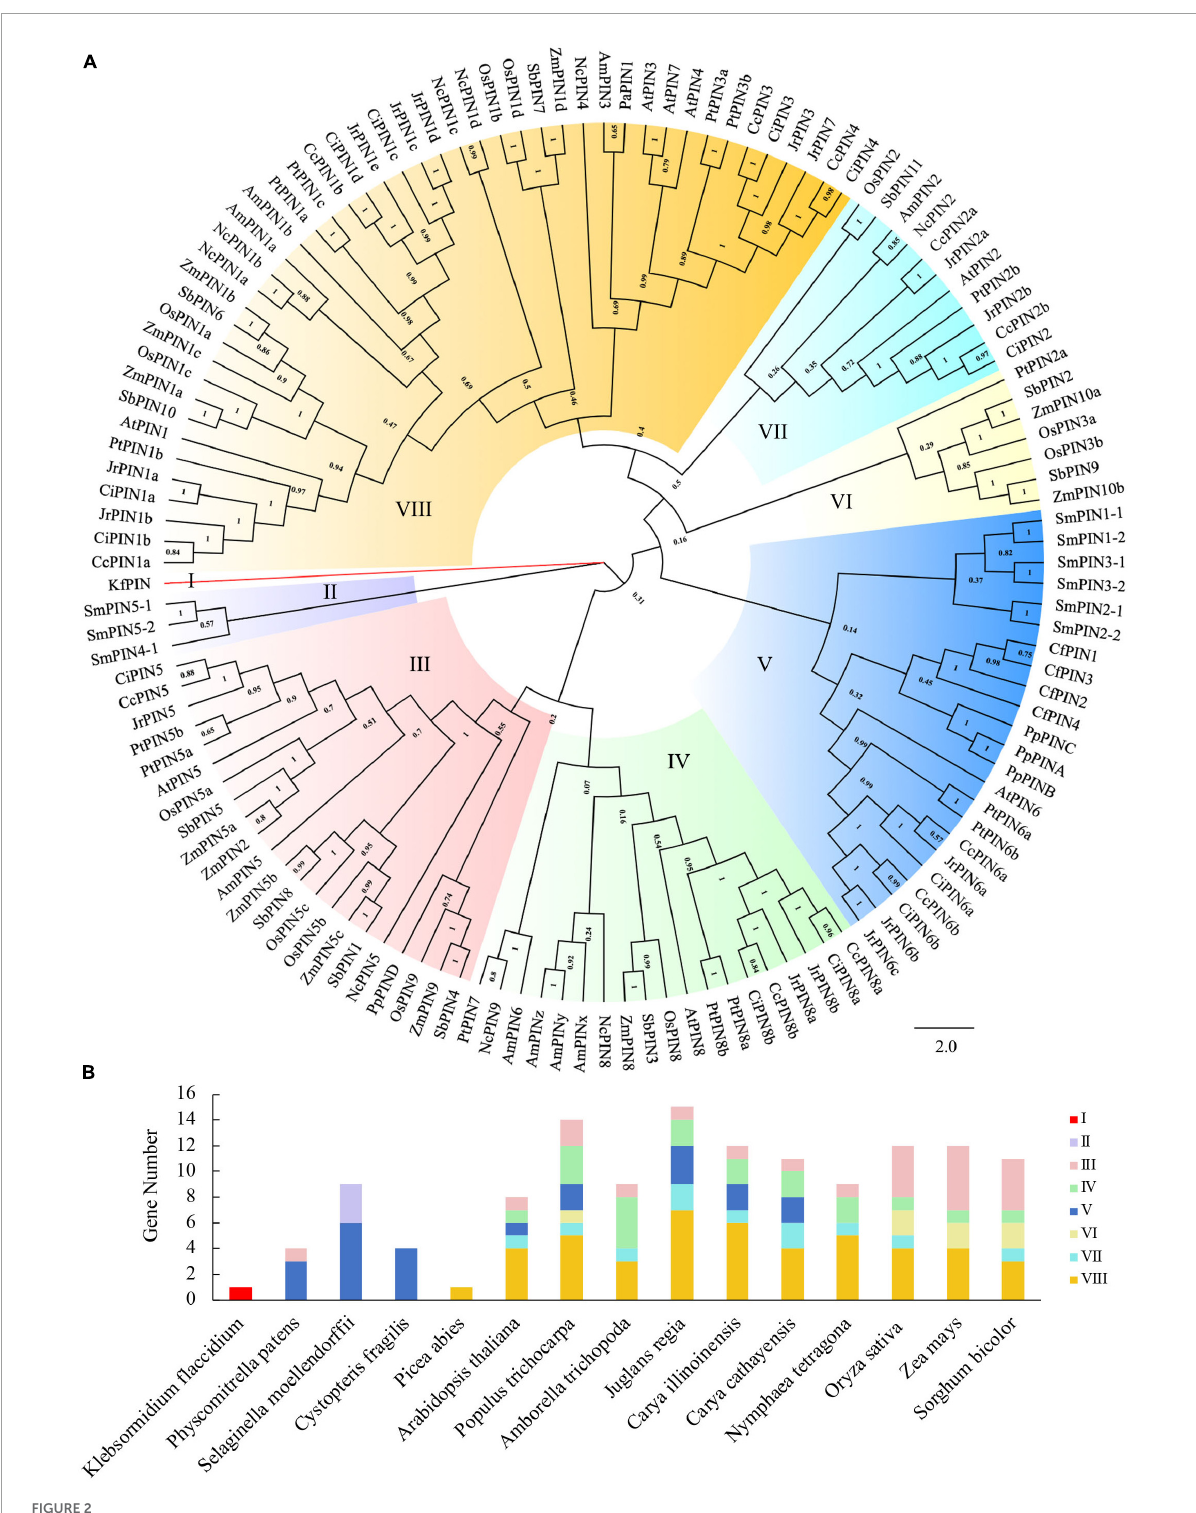
FIGURE2 Phylogenetic analysis of PIN proteins from 15 species. (A) The phylogenetic tree. (B) The number and distribution of PINs in different species. Kf, Klebsormidium flaccidium ; Pp, Physcomitrella patens ; Sm, Selaginella moellendorffii ; Cf, Cystopteris fragilis ; Pa, Picea abies ; At, Arabidopsis thaliana ; Pt, Populus trichocarpa ; Am, Amborella trichopoda ; Jr, Juglans regia ; Ci, Carya illinoinensis ; Cc, Carya cathayensis ; Nc, Nymphaea tetragona ; Os, Oryza sativa ; Zm, Zea mays ; Sb, Sorghum bicolor